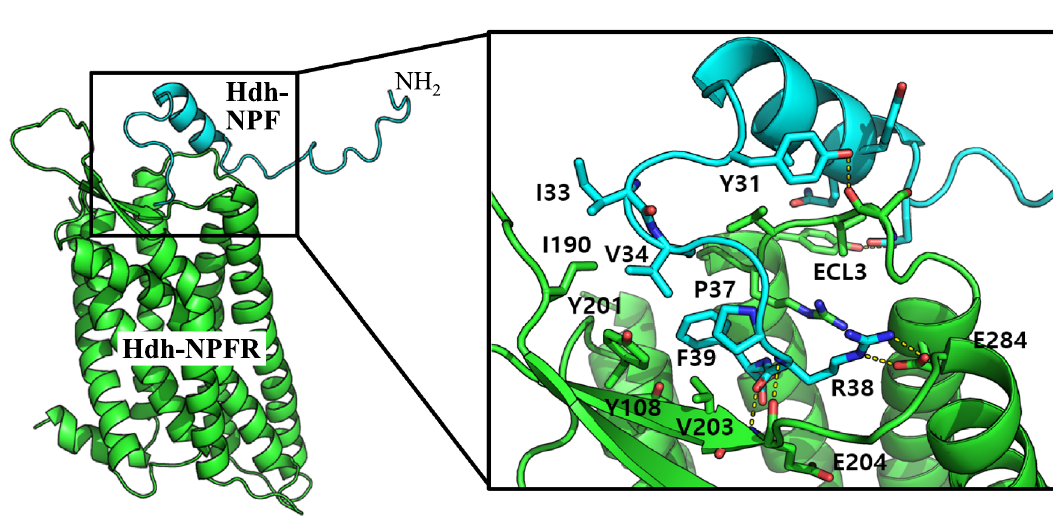
Figure 4. In silico docking model of the NPF-NPFR complex. The cartoon representation for Hdh-NPFR and Hdh-NPF is shown in green and cyan, respectively. The peptide binding interface (black box) is enlarged to show the details of the residue interactions, including R38 of Hdh-NPF and E284 in Hdh-NPFR. The helix region of Hdh-NPF (Q22–Y31) contacts the ECL3 region in Hdh-NPFR (S288–K293) connecting TMD6 and TMD7 outside the binding